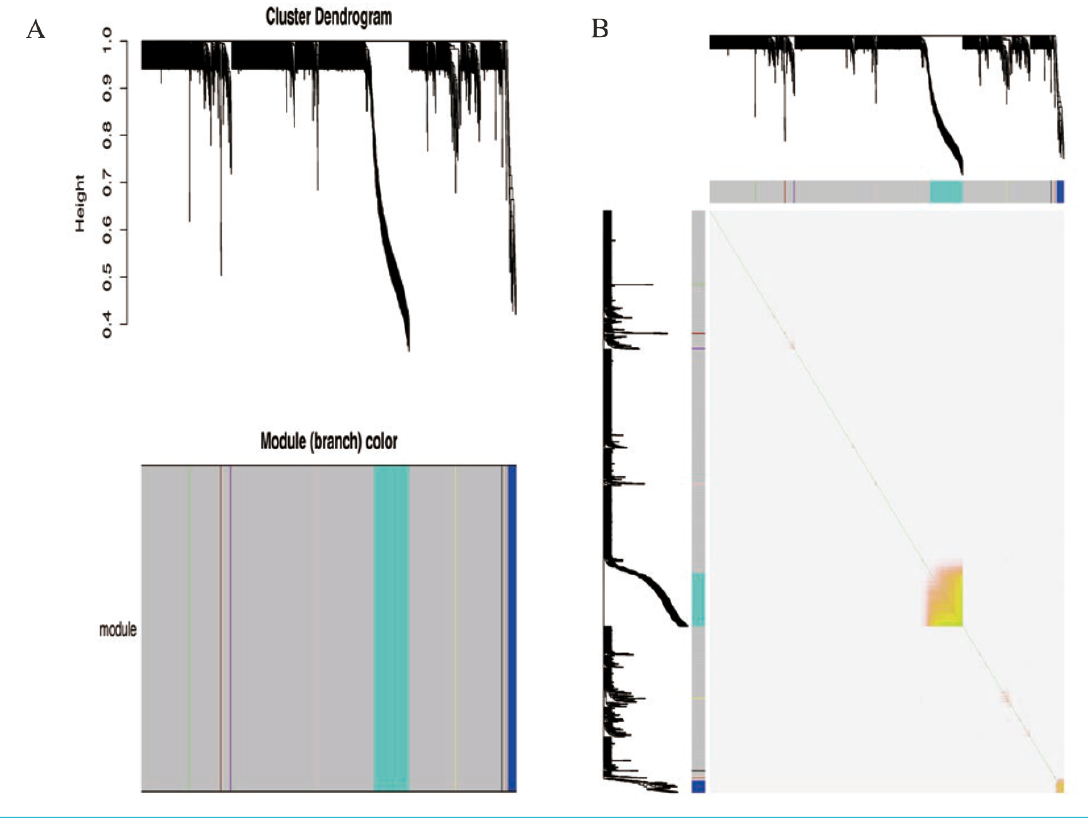
Figure 2: Gene modules identified in the WGCNA. (A) Gene dendrogram obtained by clustering the dissimilarity based on consensus Topo- logical Overlap. The colour rows indicate the corresponding modules. (B) Visualisation of the gene network using a heatmap plot. The heatmap depicts the TOM DEGs in the yellow and grey modules. Abbreviations: WGCNA, weighted gene co-expression network analysis; DEG, differentially expressed gene; TOM, Topological Overlap Matrix.